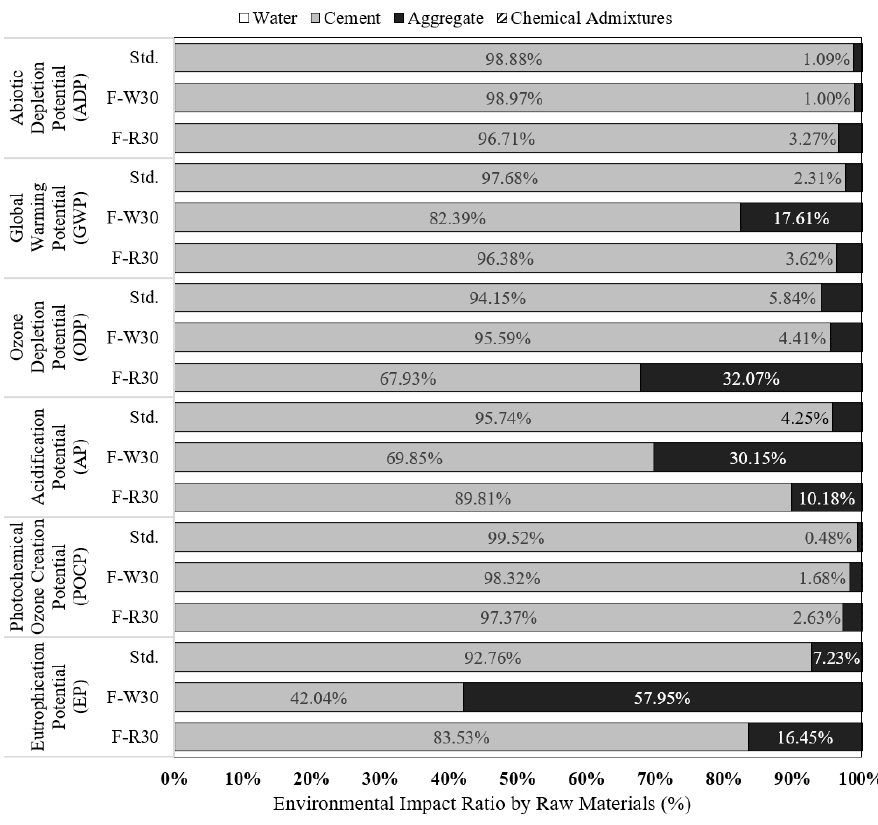
Figure 3. Environmental Impact Ratio with Respect to Raw Materials in the Standard, F-W30, and F-R30 Mixtures.